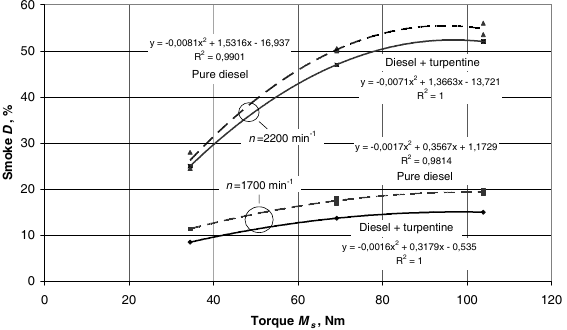
Fig 3. Dependence of exhaust gas smoke on the engine torque for run at different speed